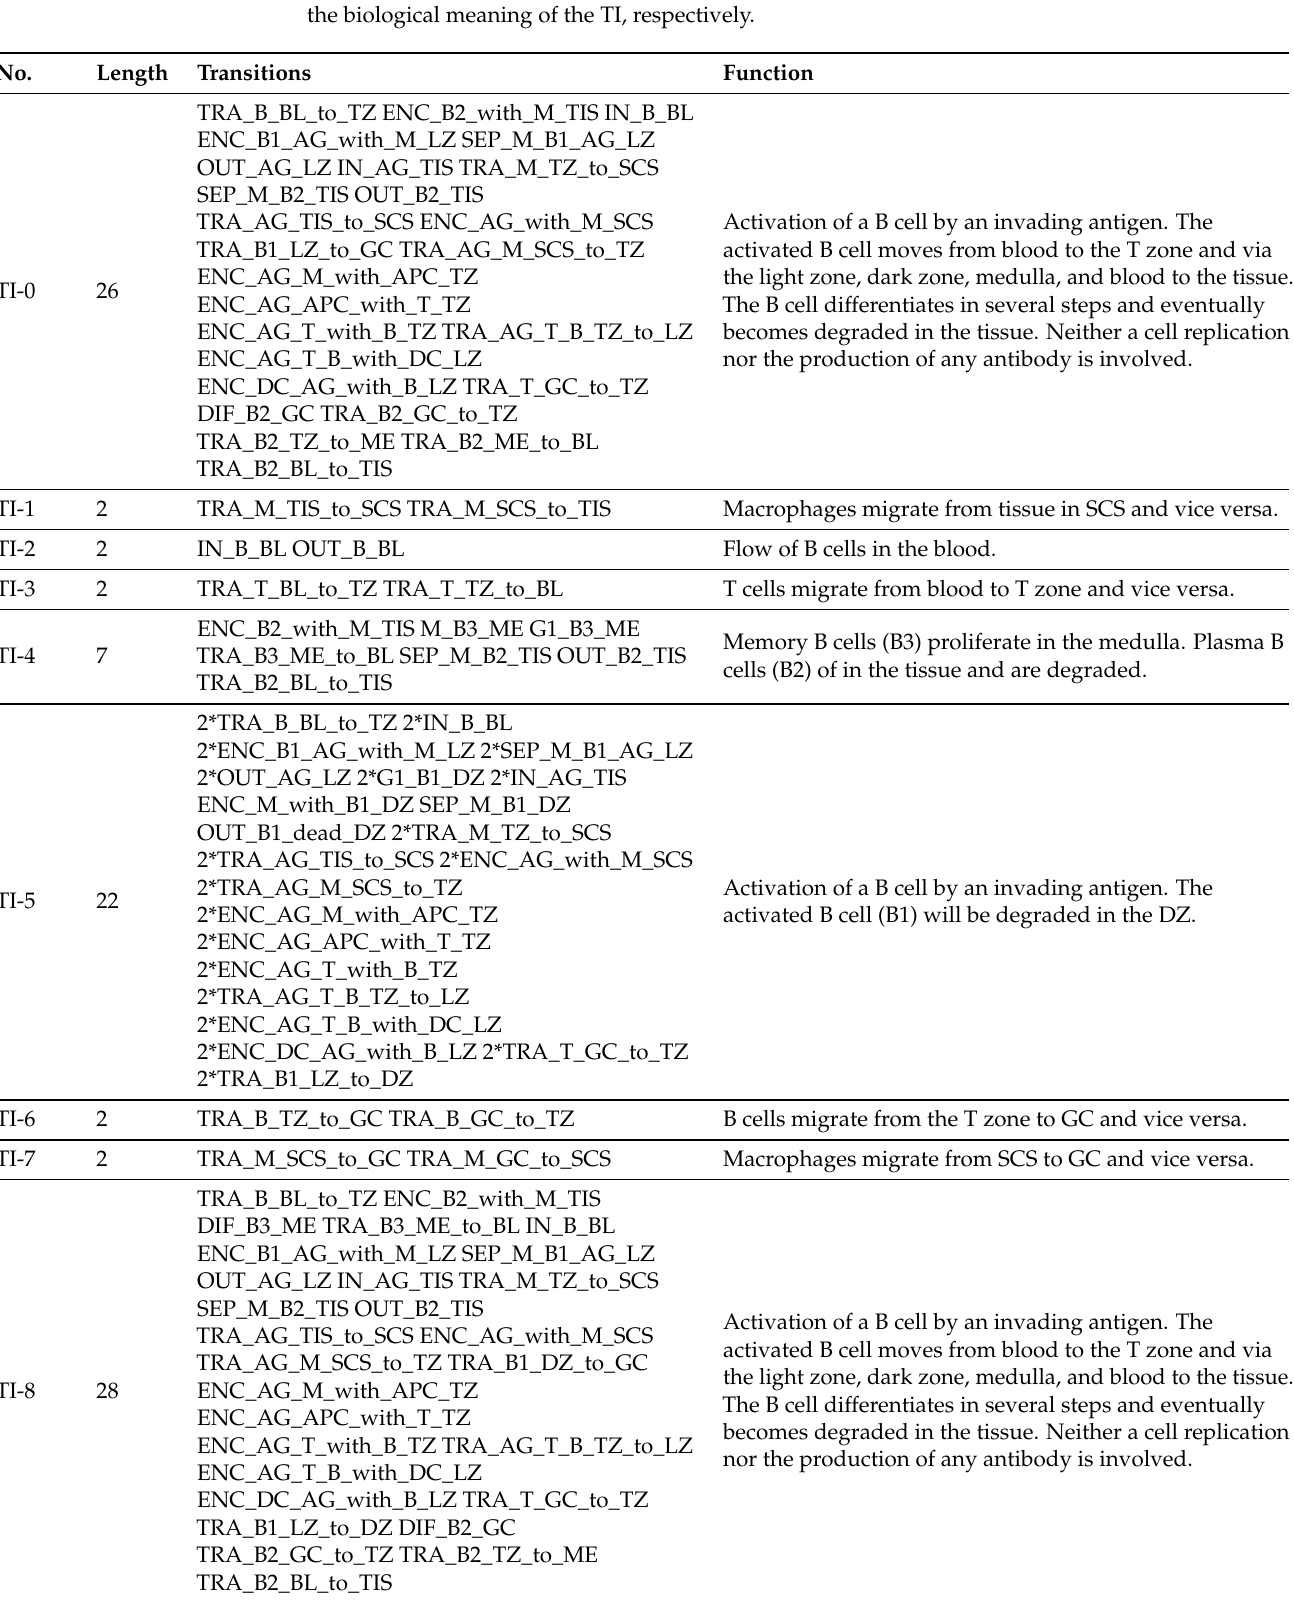
Table A5. List of 25 transition invariants (TIs). The columns ”length”, ”transitions”, and ”function” provide the number of transitions of the TI, the names of all transitions of the TI, and a description of the biological meaning of the TI,